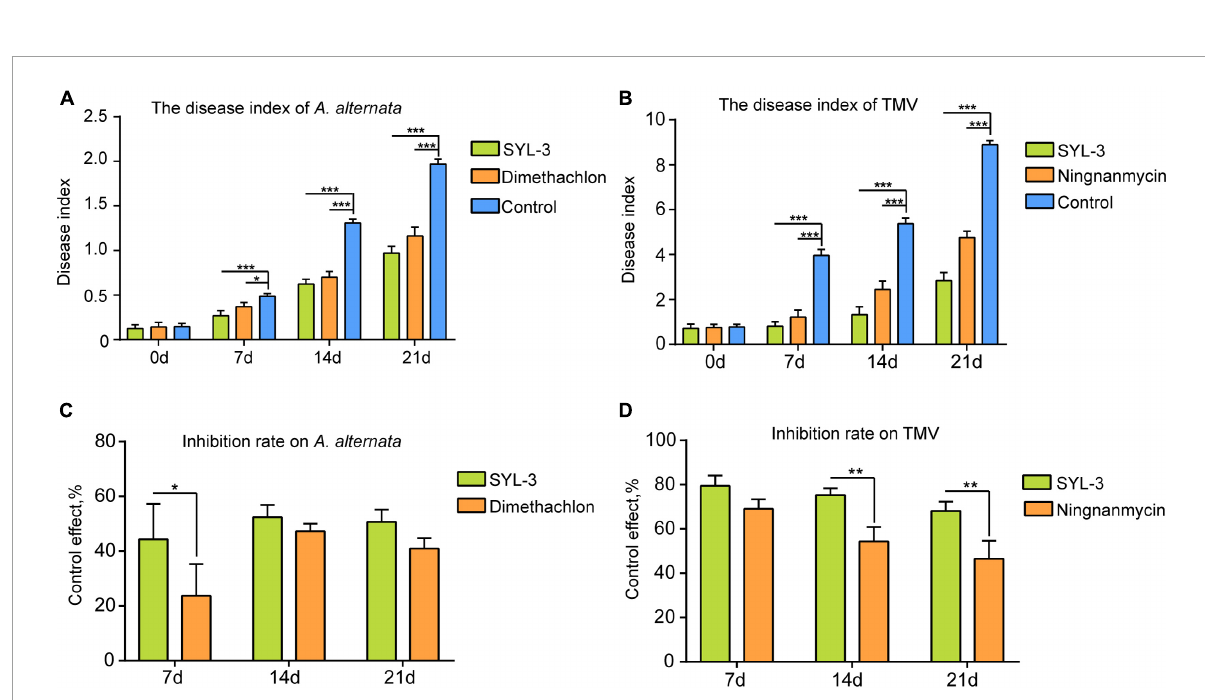
FIGURE4 Plant disease index of A. alternata and TMV and control effect of SYL-3. (A, B) The disease index of A. alternata and TMV treated with SYL-3 on different days. (C, D) Inhibition rate on A. alternata and TMV treated with SYL-3 on different days (* p < 0.05, ** p < 0.01, and *** p <